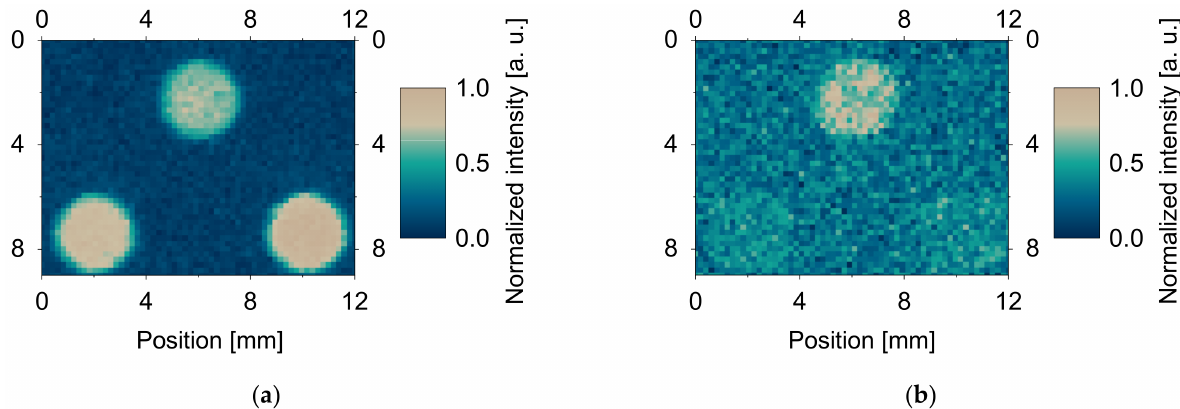
Figure 5. ( a ) THz image obtained in open-Nicol configuration. ( b ) THz image obtained in cross-Nicol